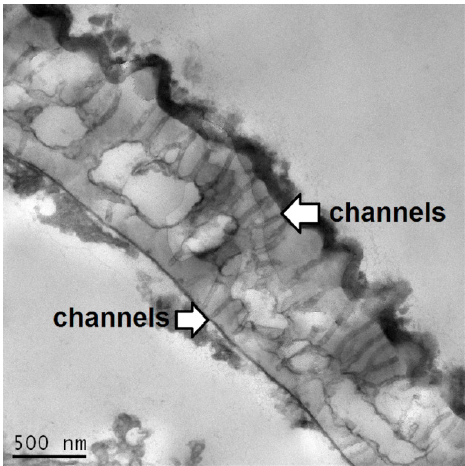
Figure 3. Transmission electron microscopy (TEM) picture of exine wall of Secale cereale showing nano-diameter ( ca. 20 nm) sized